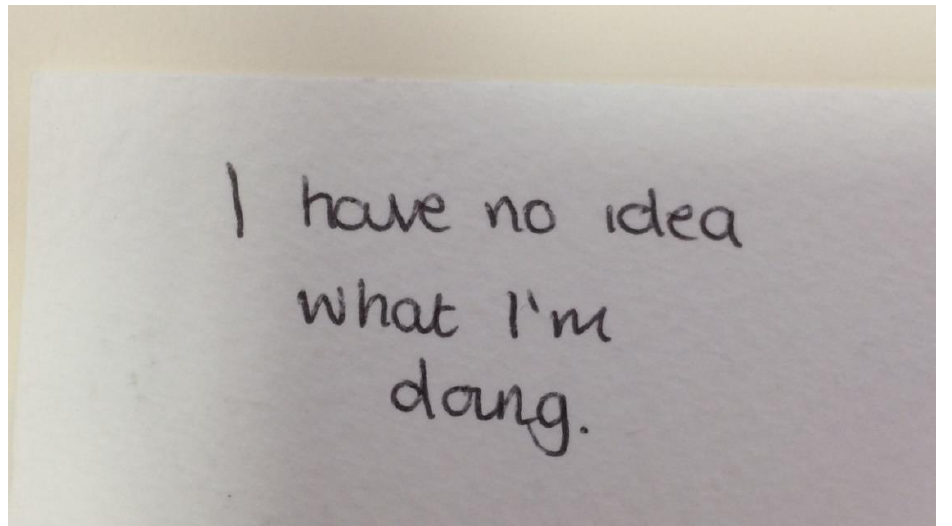
Figure 2. Thomas, J (2016). Undergraduate student feedback.